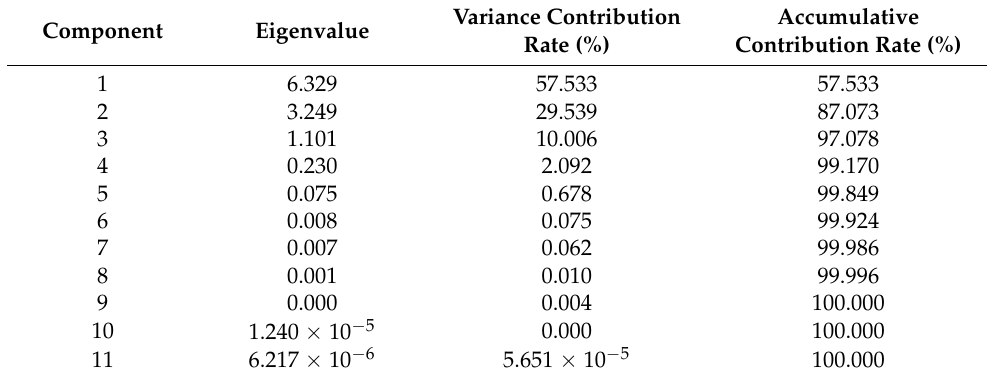
Table 6. Statistics of variance-contribution rate. Table 7. Component matrix.